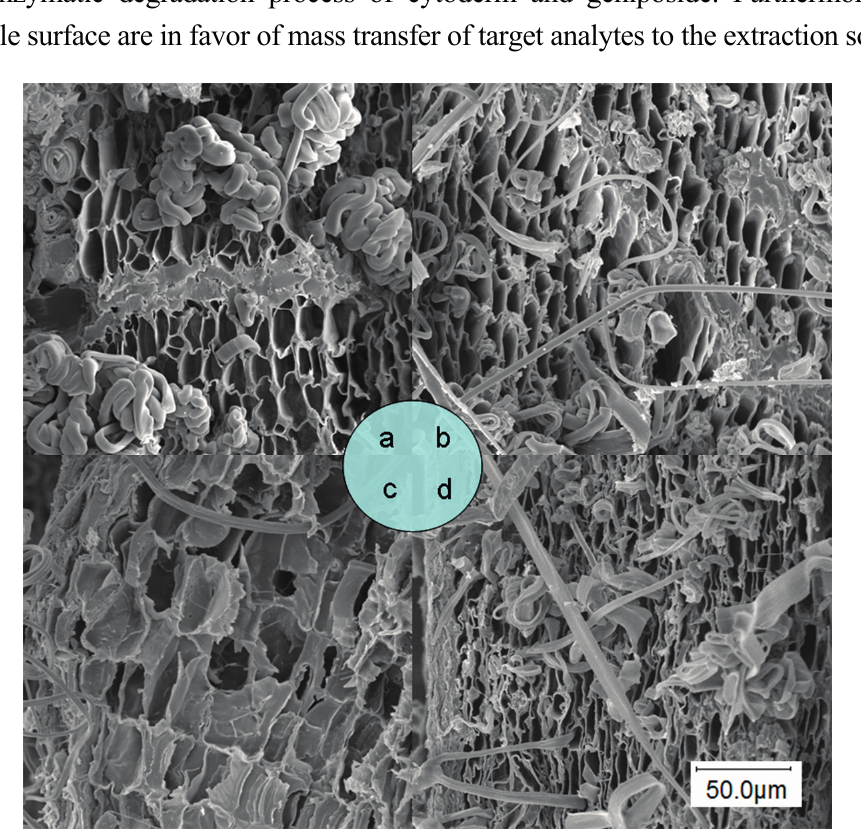
Figure 6. Scanning electron micrographs of bark of E. ulmoides : ( a ) raw material; ( b ) degreased sample; ( c ) sample after EHSE; and ( d ) sample after water